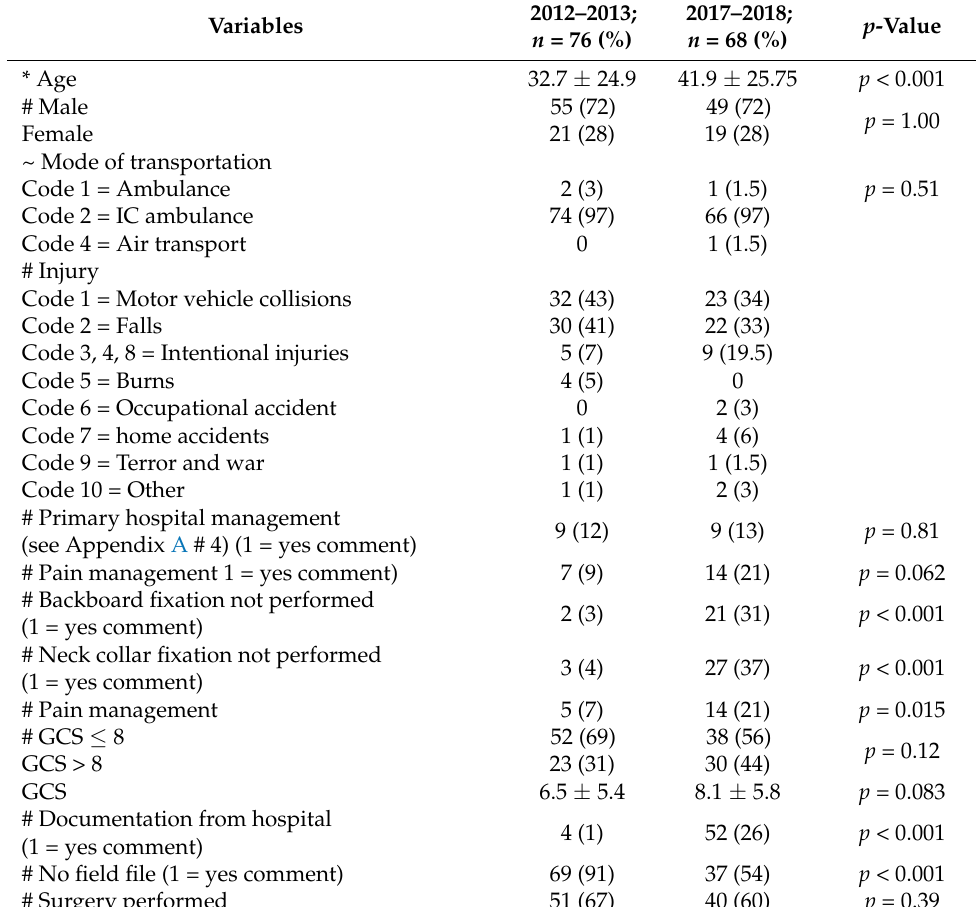
Table 1. Pre-hospital team feedback.